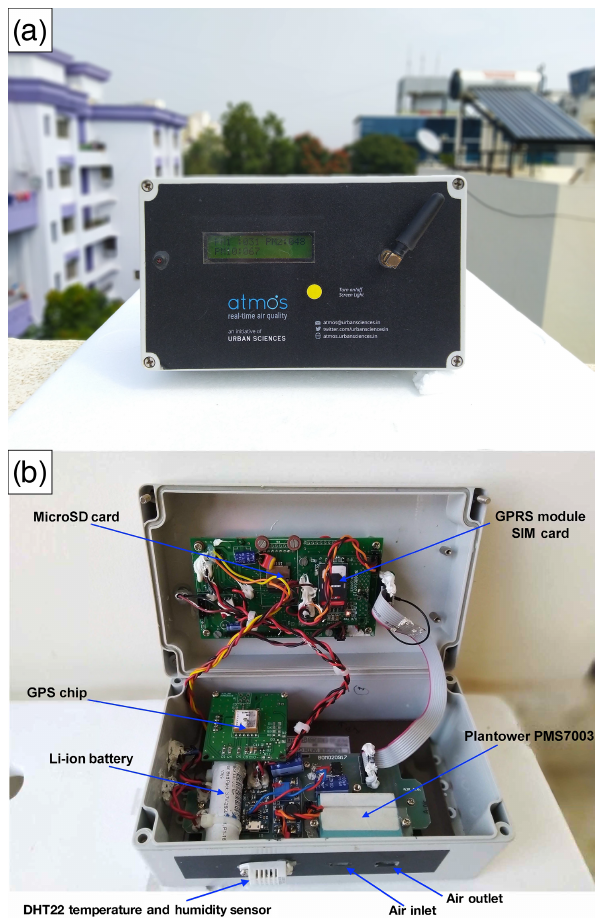
Figure 1. (a) Front view of the low-cost node. (b) Key components of the low-cost